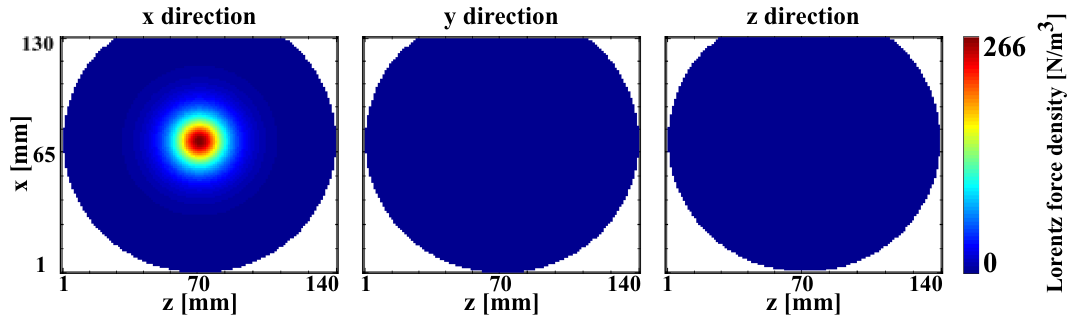
Figure 2. Simulated Lorentz force density maps in phantom A of the first experiment. Maps are located in the imaging plane of Fig. 1. The applied current was 137.5 mA peak-to-peak at a frequency of 90 Hz. A significant Lorentz force component is observed along the x axis, but it is negligible along the y and z